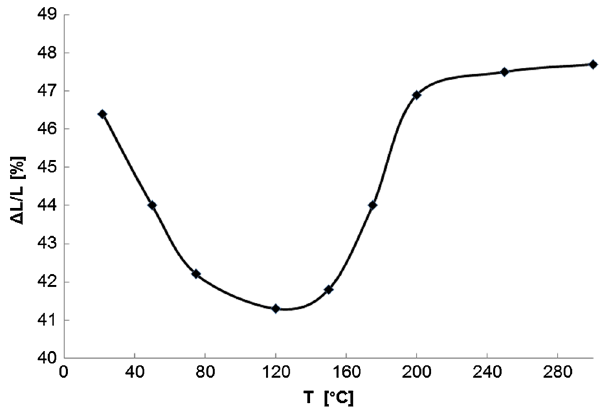
FIG. 1. Elongation at break vs temperature for high purity